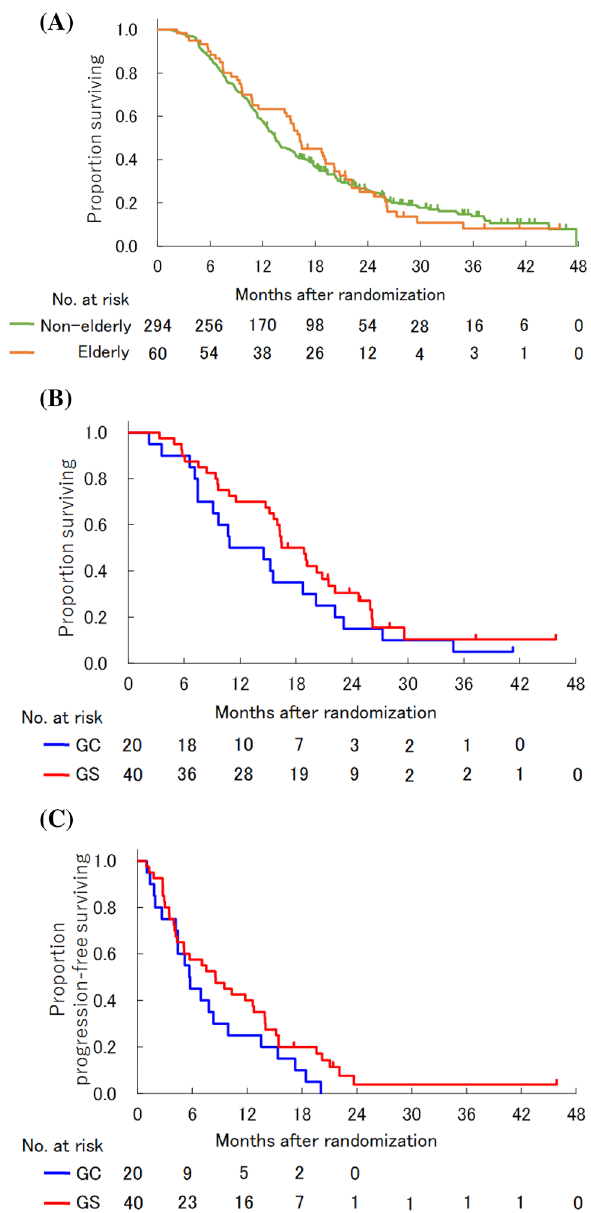
Figure 2. Overall survival and progression-free survival (intention-to-treat population). ( A ) Overall survival for elderly and non-elderly patients. ( B ) Overall survival for elderly patients in the GC and GS group. ( C ) Progression-free survival for elderly patients in the GC and GS group. Vertical lines on curves indicate patients censored on the date of their last follow-up. GC, gemcitabine plus cisplatin; GS, gemcitabine plus